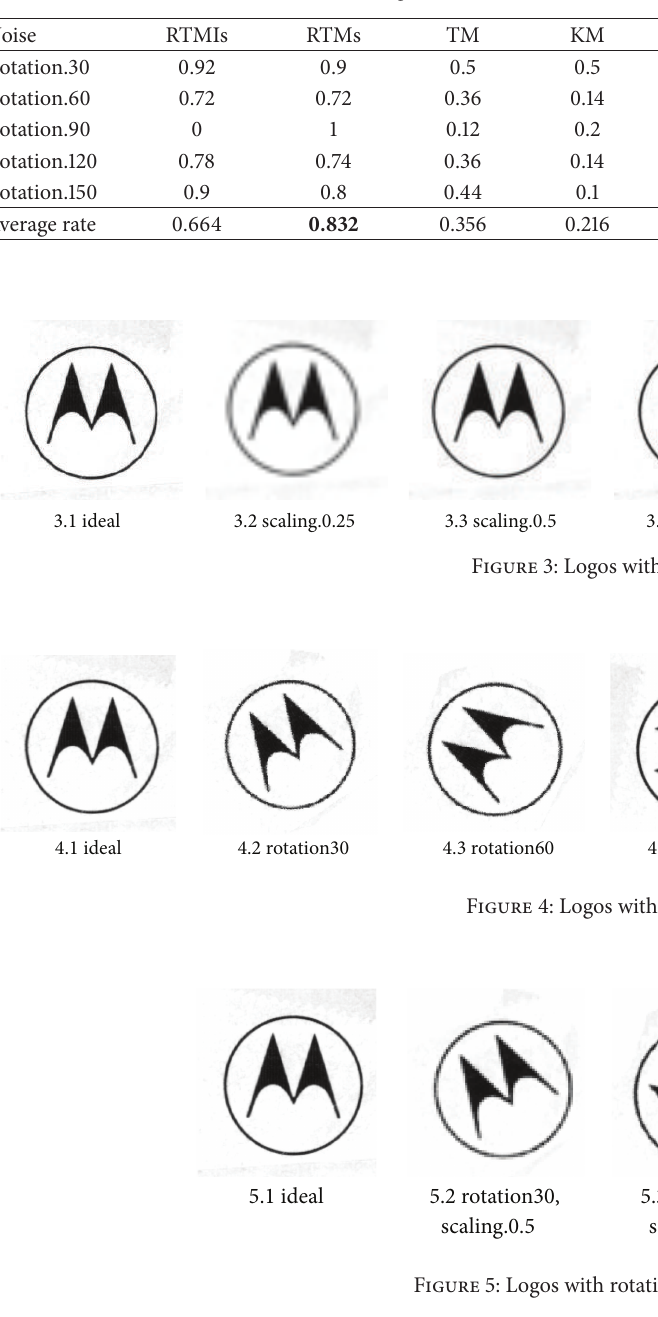
Table 3: Recognition rates of different moments about logos with rotation.